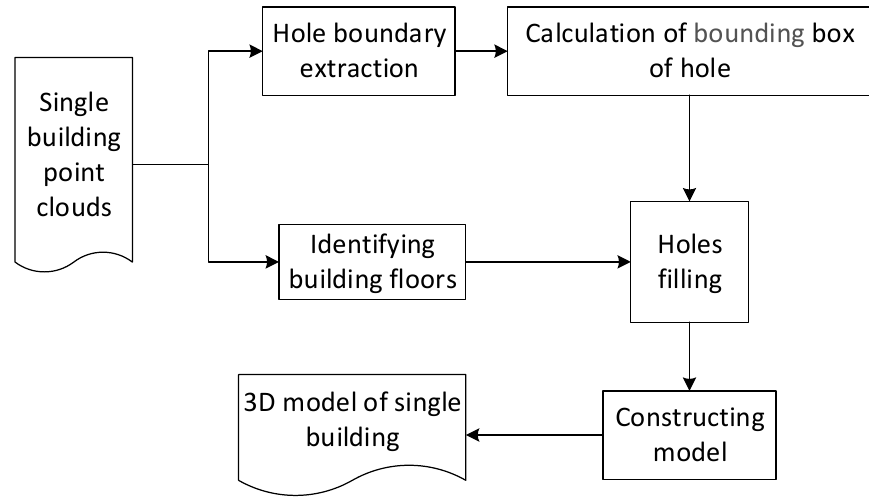
Figure 2. Flow diagram of the proposed approach.